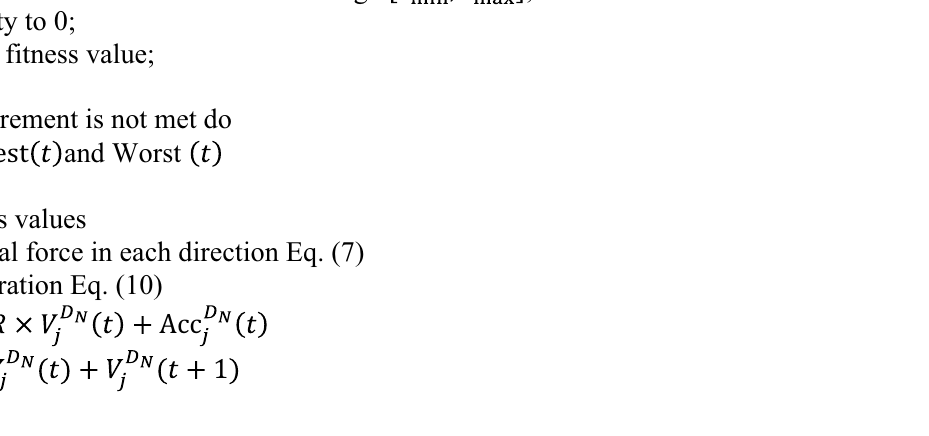
Algorithm 1 Pseudo-code of AEFA Initialization of Population size within search